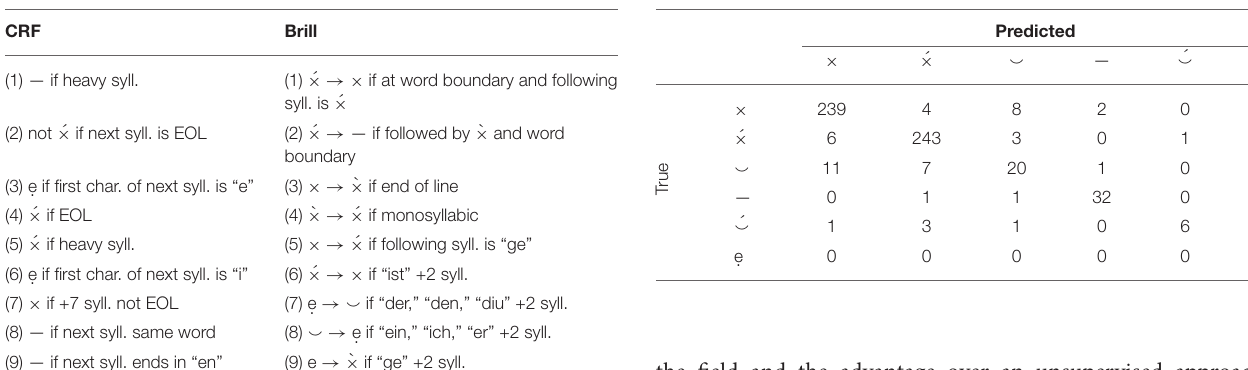
TABLE 5 | CRF confusion